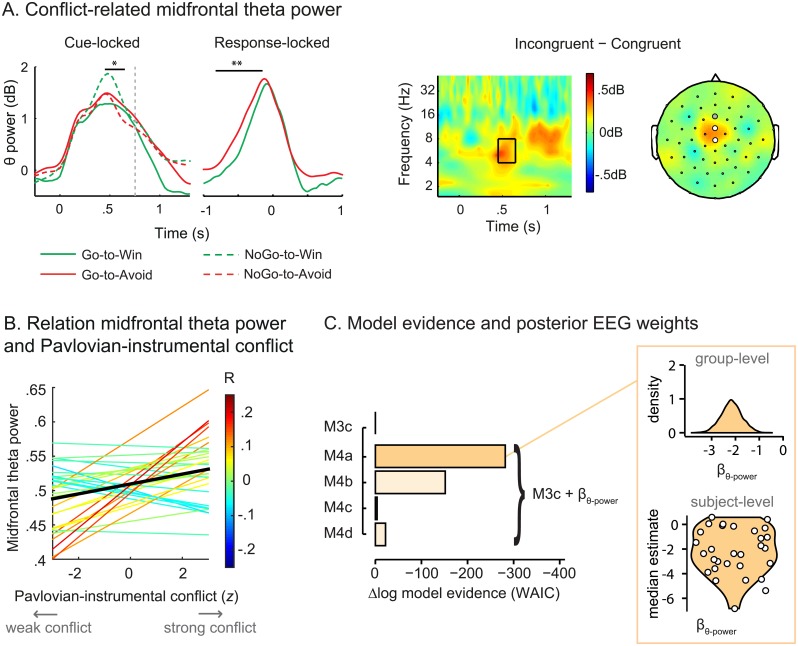
Cue-related midfrontal theta power.(a) Left: Time-wise permutation testing reveals one cue-locked (450 ms–650 ms) and response-locked (–826 ms to –150 ms) time window during which midfrontal theta power (4 Hz–8 Hz) increased for motivationally incongruent trials (NoGo-to-Win, Go-to-Avoid) relative to congruent trials (Go-to-Win, NoGo-to-Avoid). *p < 0.05; **p < 0.01. Right: Cue-locked contrast of motivational conflict. Time-frequency plot for the midfrontal channels, with the resulting time window indicated by the box. Topoplot for theta power in the resulting time window with the significant (nonsignificant) a priori midfrontal channels indicated by white (gray) discs (post hoc Bonferroni corrected alpha = 0.017). The a priori channels showing a significant cue-locked congruency effect were used in the computational models and served as seeds for the connectivity analyses. (b) Within-subject regression lines (colored) of trial-by-trial midfrontal theta power and Pavlovian–instrumental conflict according to model M3c. Across subjects (black line), there is a positive association between the level of conflict and midfrontal theta power (p = 0.007), putatively reflecting the detection of the conflict. Midfrontal theta power did not significantly covary with trial number (p = 0.94), rendering a confound of trials on task unlikely. (c) Model evidence relative to winning behavioral model M3c. Addition of the βθ-power parameter improves model fit most when scaling the impact of theta power on the Pavlovian bias (M4a) rather than scaling the impact on the instrumental contribution (M4b), the balance between the Pavlovian and instrumental contribution (M4c), or the instrumental learning bias (M4d). The negative βθ-power parameter estimates indicate that the conflict-related increases in midfrontal theta power were associated with reduction of the Pavlovian response bias. Underlying data can be found at http://hdl.handle.net/11633/di.dccn.DSC_3017033.03_624. WAIC, Watanabe–Akaike Information Criterion.